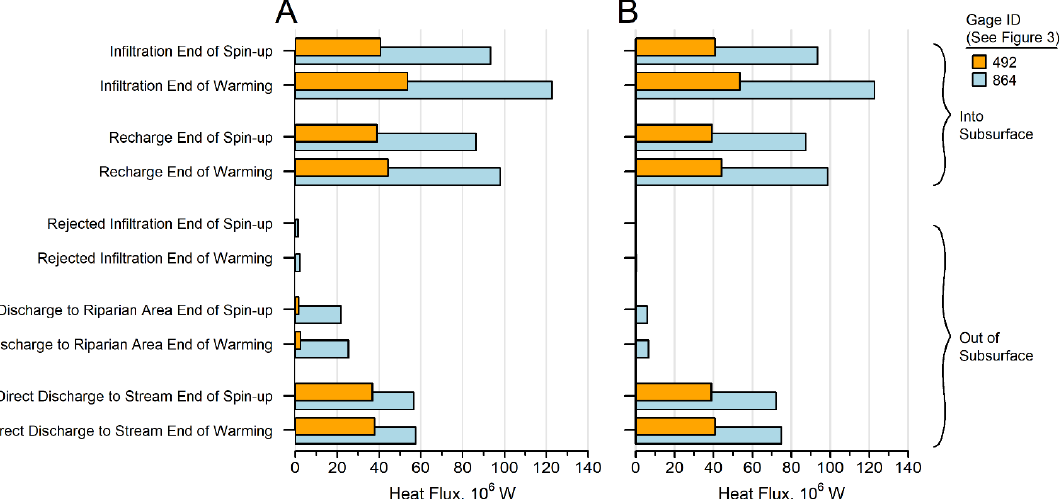
Figure 9. Convective heat flux (Watts) accumulated over contributing basins upgradient of two gage locations. ( A ) MID_TRENDED simulation. ( B ) HI_TRENDED simulation. Infiltration flux is compared to flux transmitted by down-system pathways. Convective flux for each pathway corresponds to the average for last year of spin- up (“end of spin - up”) and to the average of last 10 years of warming (“end of warming”).